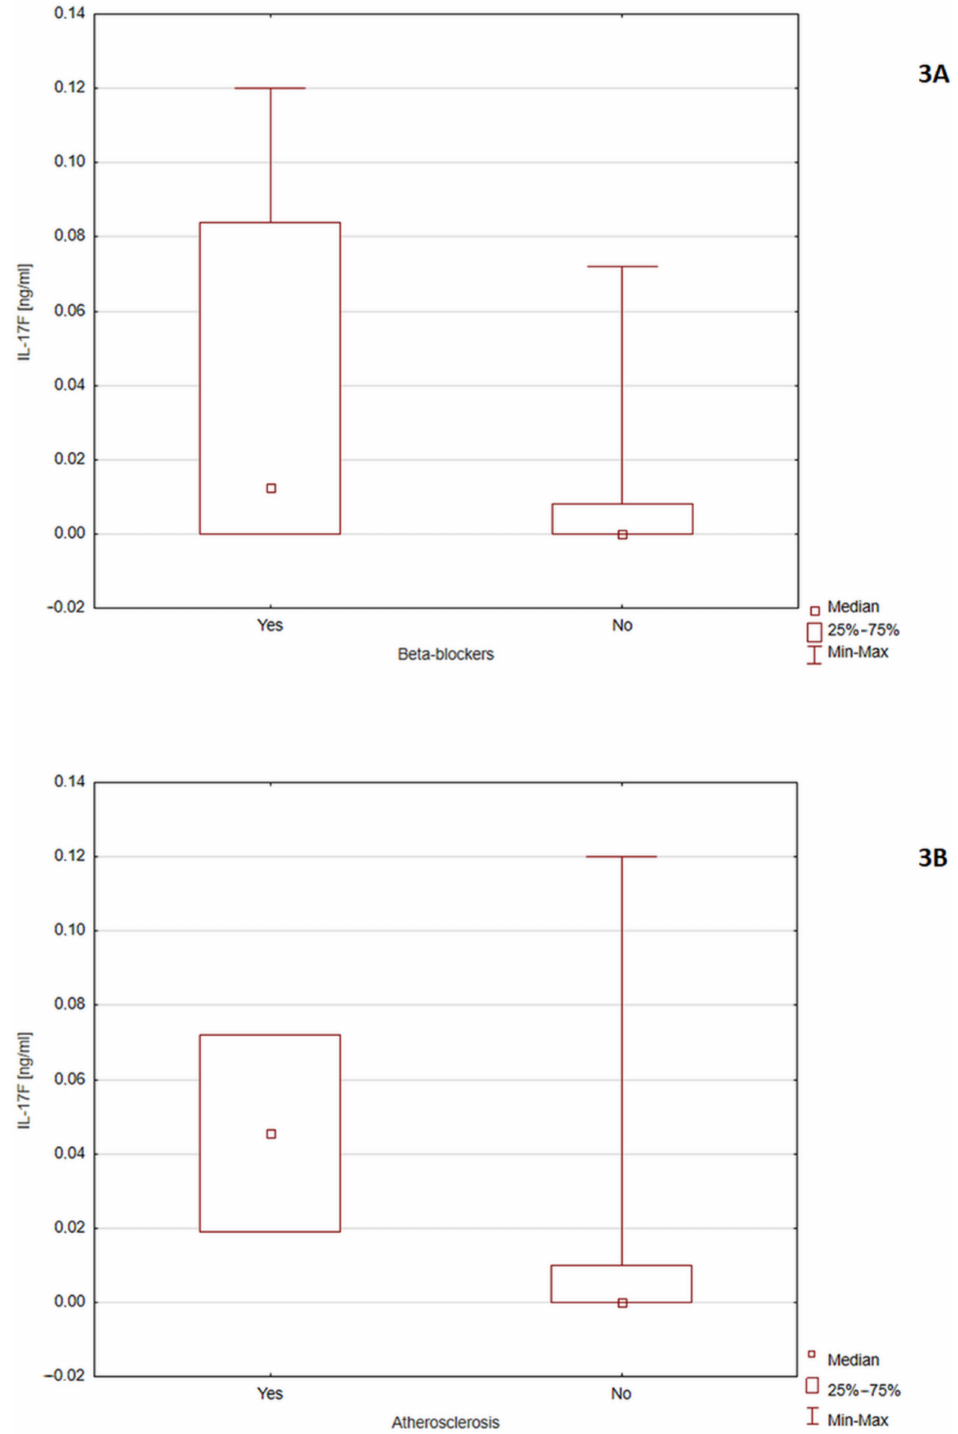
Figure 3. ( A ) comparison of IL-17F levels in people with and without atherosclerosis ( p = 0.04) and ( B ) people using and not taking beta-blockers ( p = 0.024). Individuals who often consumed confectionery bread showed a higher level of IL- 17A (r = 0.22, p = 0.046), while the respondents who often consumed confectionery bread (r = 0.25, p = 0.020) and breakfast cereals (r = 0.28, p = 0.011) had a higher level of IL -17F. (r = − 0.22, p = 0.043) and vegetables (r = − 0.25, p = 0.026) suppressed the level of